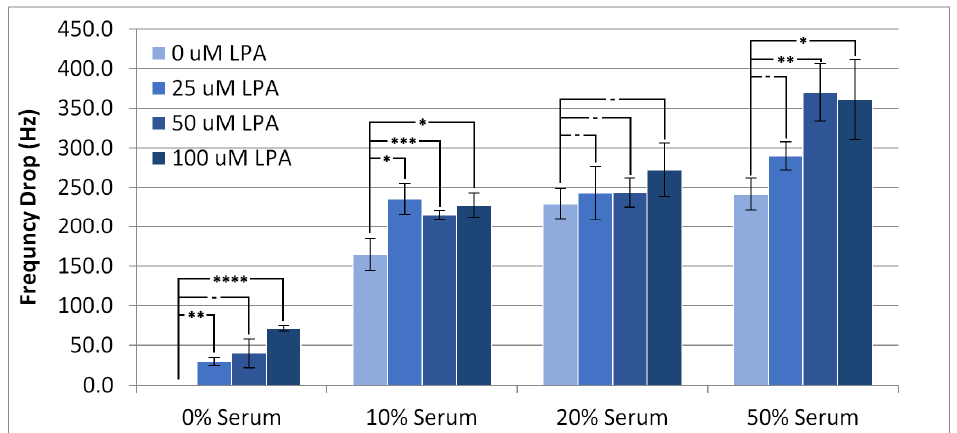
Figure 2. Frequency drop of the TSM signal on addition of PBS/serum samples containing LPA. Statistical significance using t -test shown by asterisks: (-) no significant difference, (*) 90% confidence, (**) 95% confidence, (***) 98% confidence.